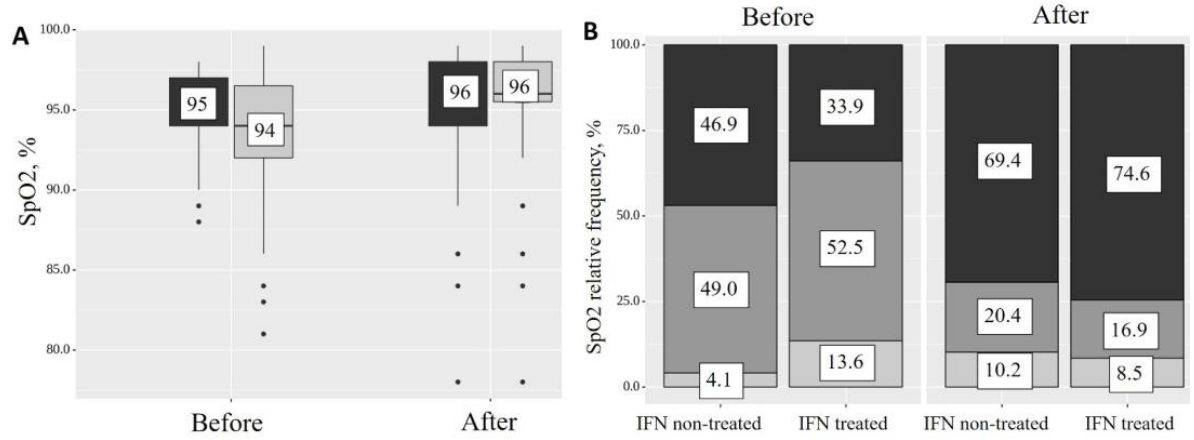
Table 3. Analysis of the level of SpO2 before and after IFN-α2b treatment.